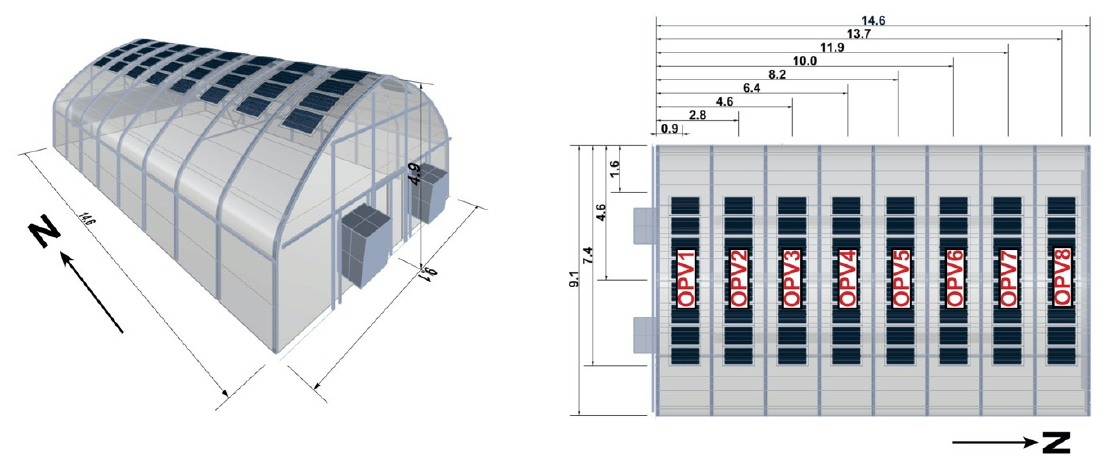
Figure 4. 3-D model of greenhouse with 8 installed OPV arrays from the southwest view ( left ) and the top view ( right ), with the OPV array identifiers labeled.